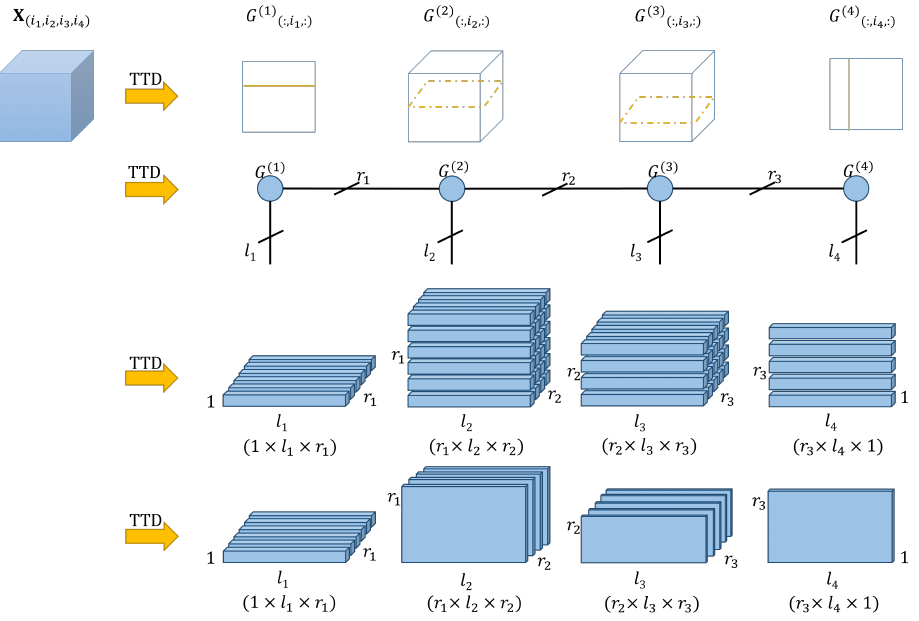
Figure 1. TT-decomposition of 4-dimensional tensor X